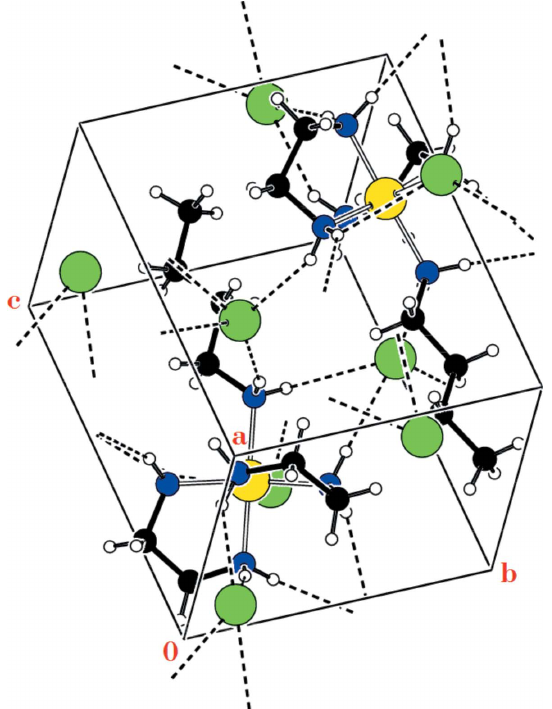
Figure 2 The packing of the title compound viewed along the a axis. Dashed lines indicate hydrogen bonds.